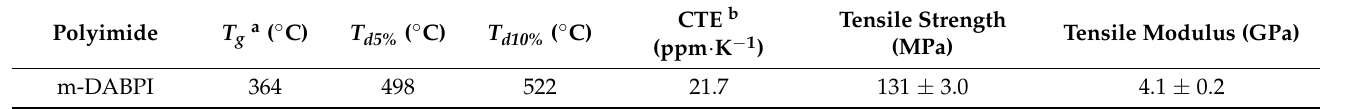
Table 1. Thermal and mechanical properties of the m-DABPI film.